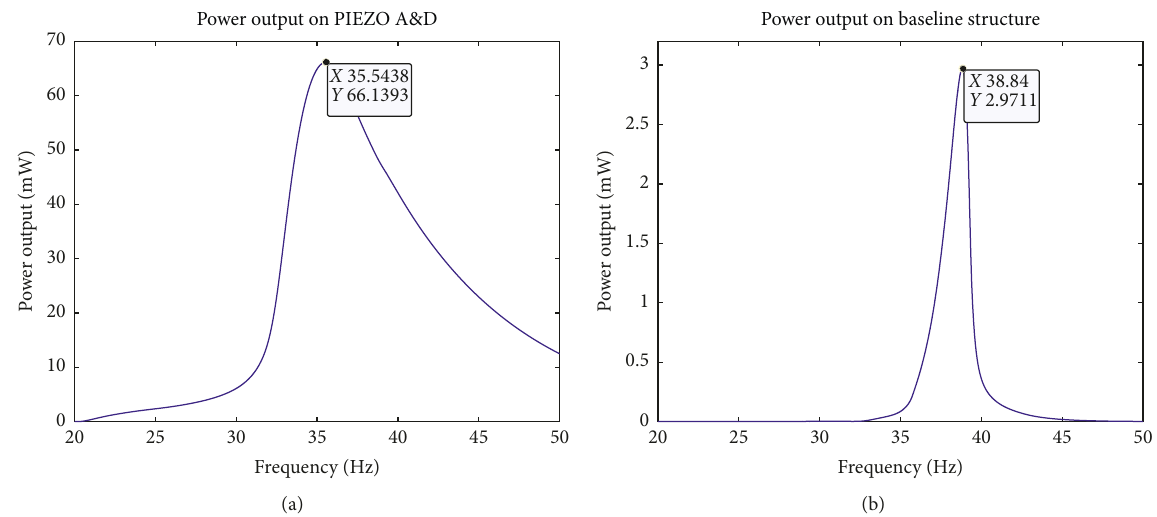
Figure 15: Comparison of power output on the designed EMM model and the baseline EH (the baseline energy harvester). (a) EMM model. (b) Baseline EH.